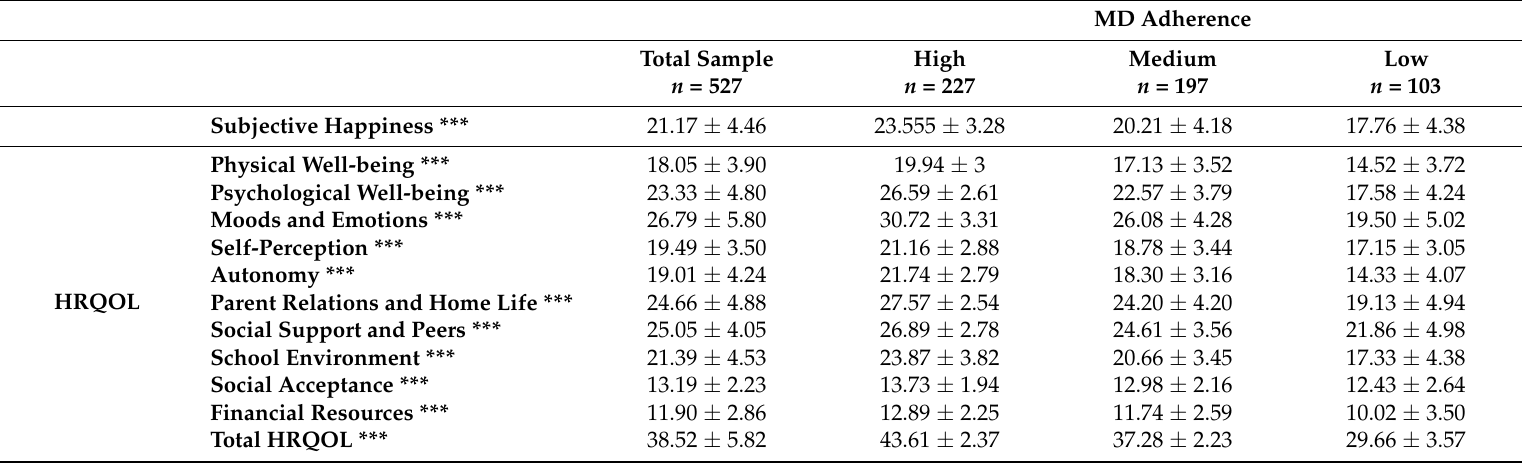
Table 3. Subjective happiness and health-related quality of life (HRQOL) dimension scores (mean ± standard deviation) in the total sample of adolescents ( n = 527) and in each subgroup with high ( n = 227), medium ( n = 197) and low ( n = 103) adherence to a Mediterranean